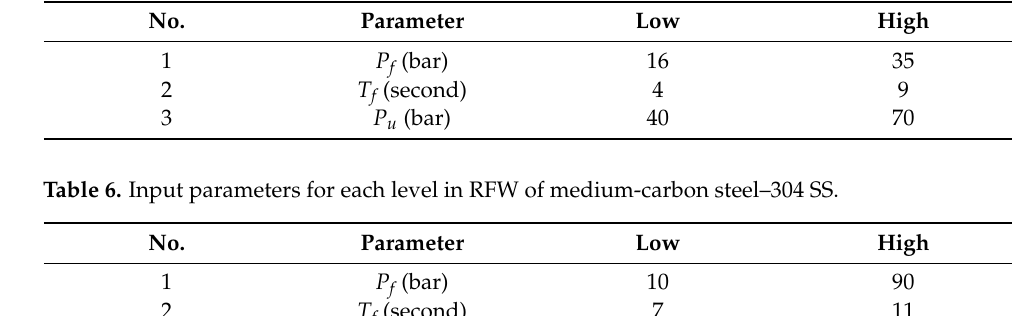
Table 5. Input parameters for each level in RFW of low-carbon steel–304 SS.